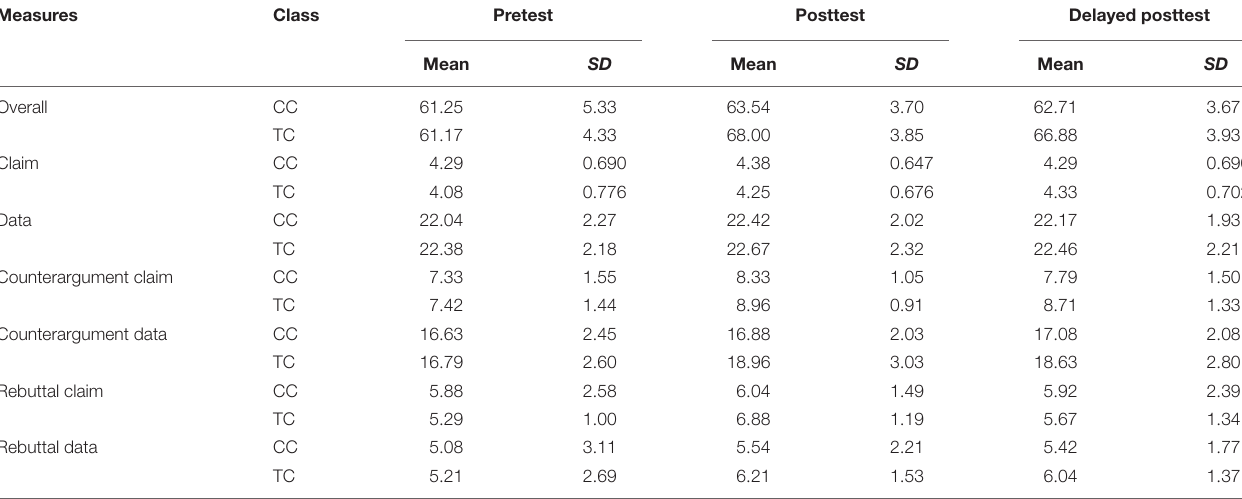
TABLE 2 | Descriptive statistics for holistic and analytic scores of the quality of argument across tests. Measures Class Pretest Posttest